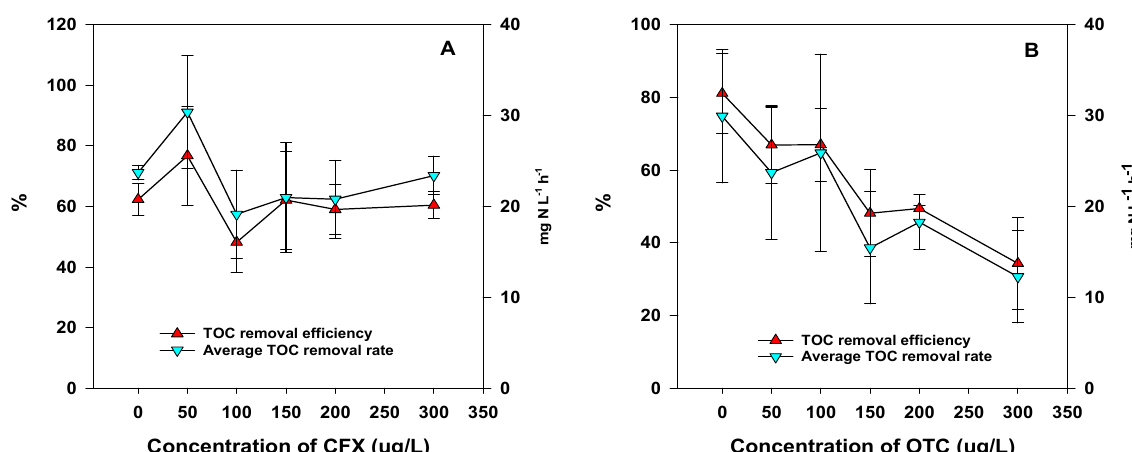
Figure 3. Variation of TOC under aerobic denitrification processes in the presence of CFX ( A ) and OTC ( B ).